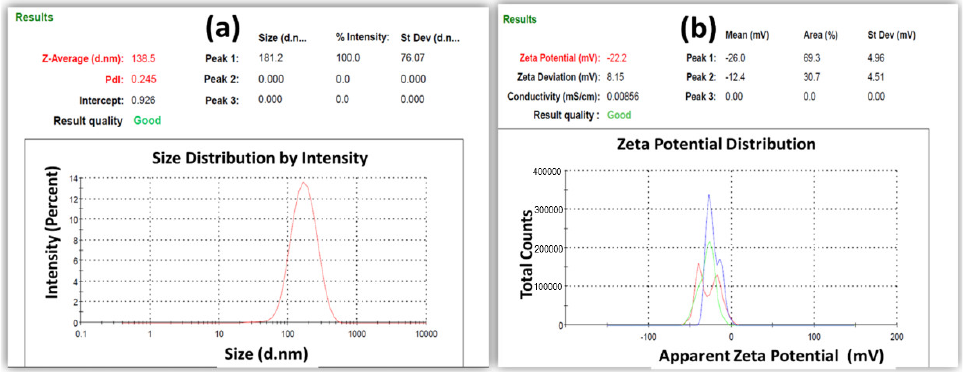
Figure 1. ( a ) Particle sizes and polydispersity index ( b ) Zeta potential of coumarin-loaded SLN dispersions (Three colored lines represent that the same zeta potential was taken three times, and these colors is computer generated.).